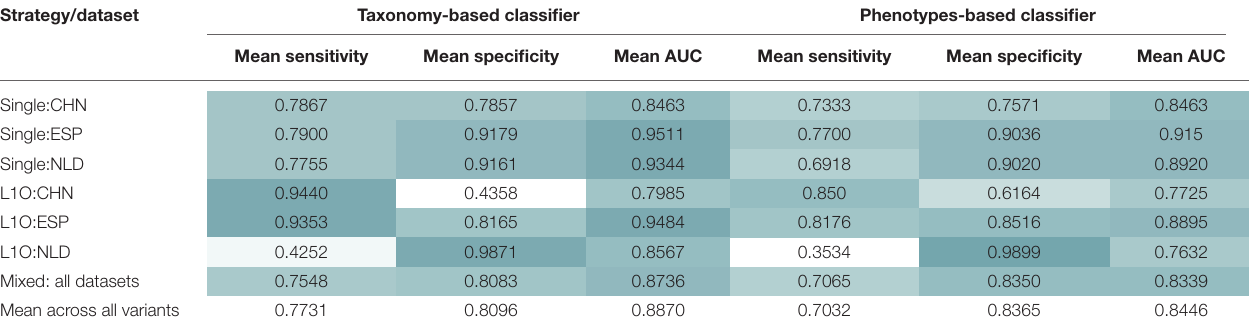
TABLE 3 | Mean performance characteristics of the taxonomy- and phenotype-based CD classifiers over 10 classification iterations.